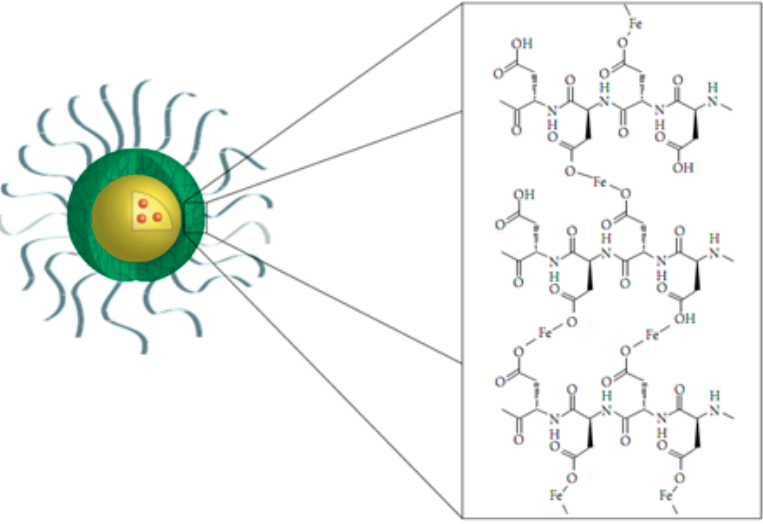
Figure 7. Diagram showing stabilized polymer micelles by cross linking the poly(aspartic acid) block with metal via metal acetate bonds. These bonds are break at low pH. Reproduced with permission from [157]. Copyright 2012 Jonathan Rios-Doria et al.